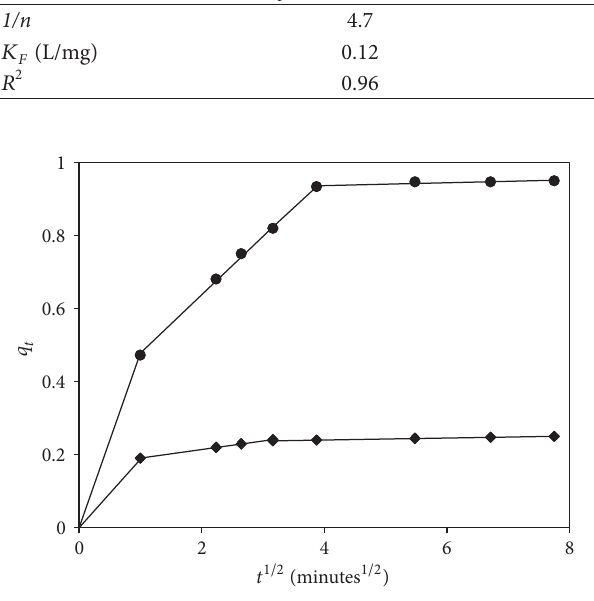
for REEs 1/𝑛𝑛 > 1